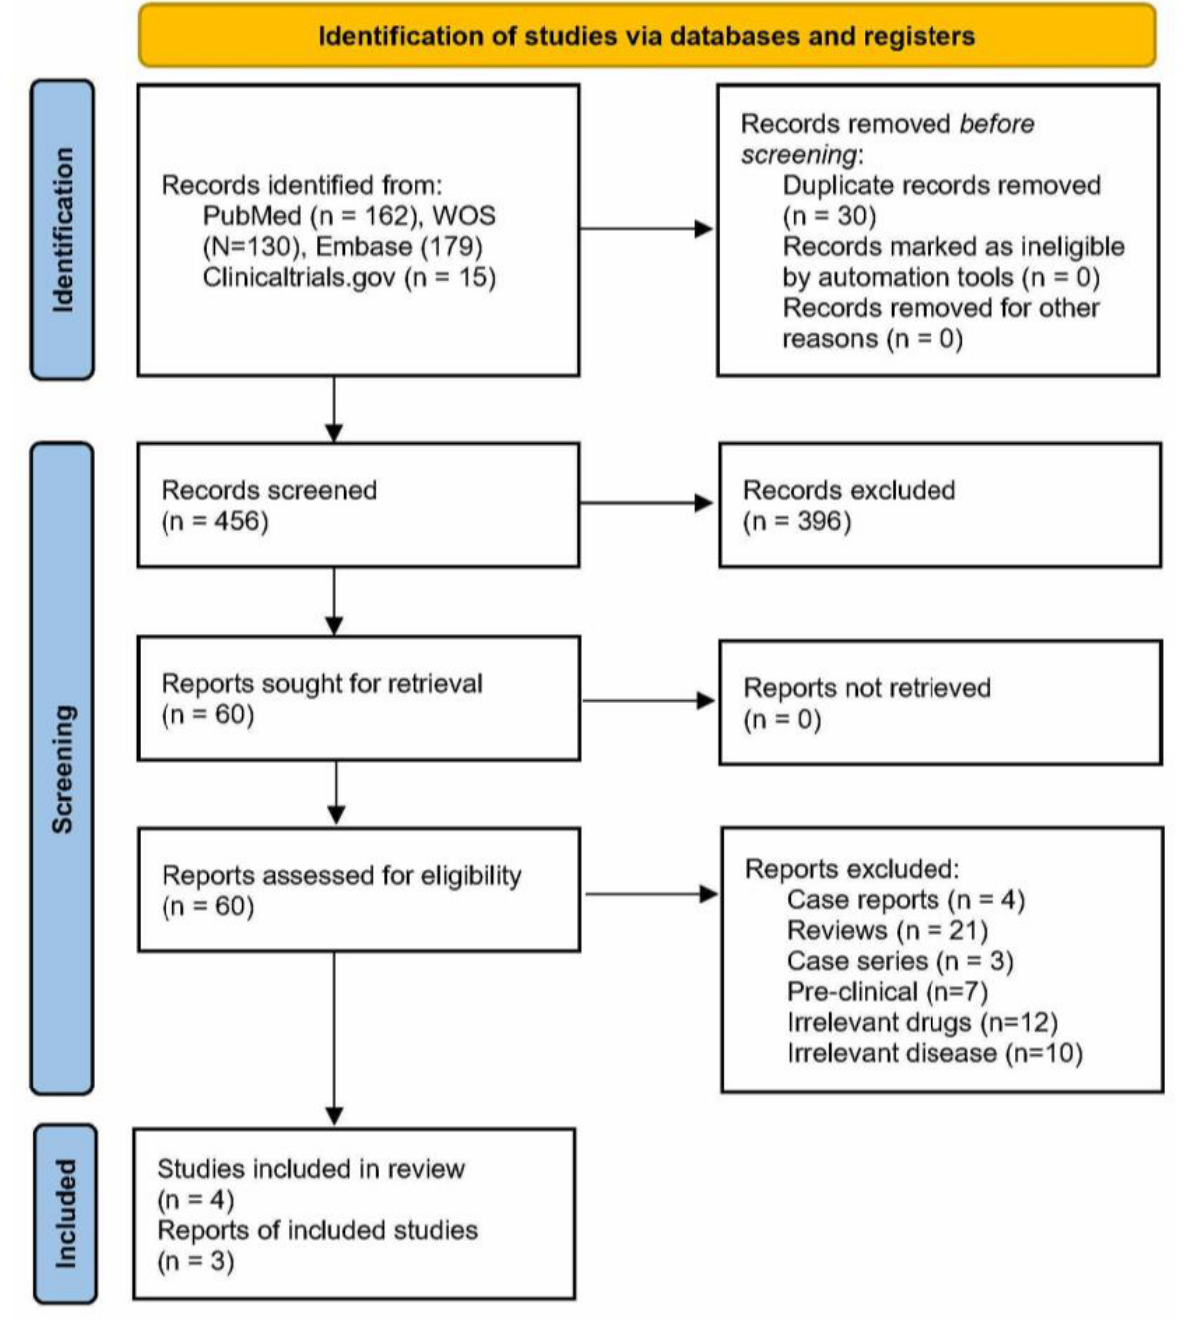
Figure 1. Prisma flowsheet of selection of articles.